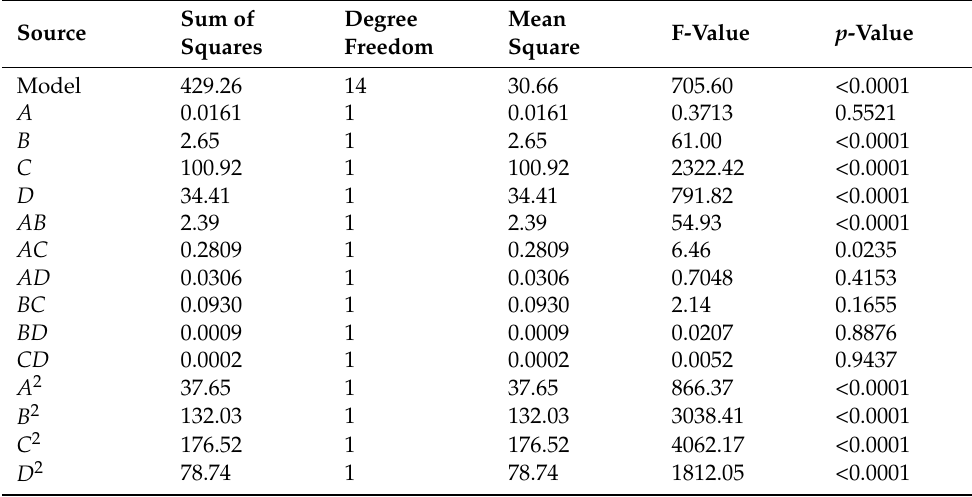
Table 3. Analysis of variance of the